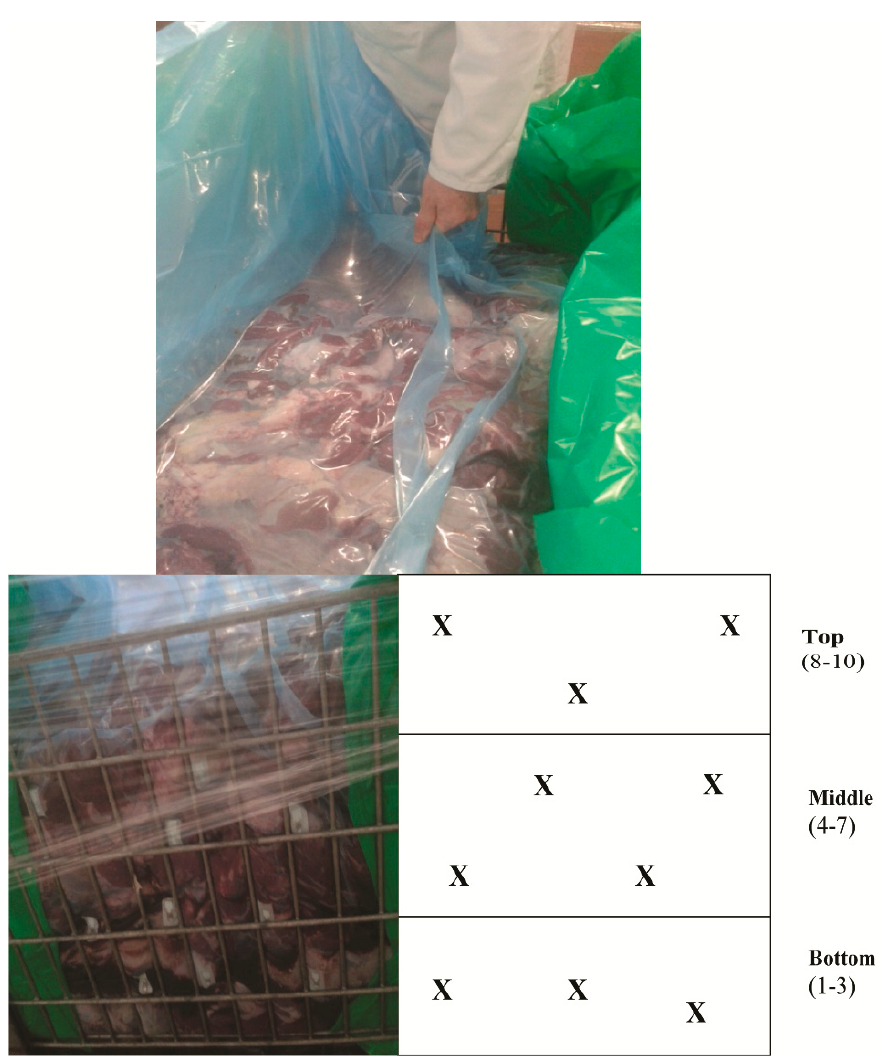
Figure 1. Top view of a bulk bin with vacuum-packaged meat ( top ) and its side view in a bin ( bottom left ) showing the location of individual O 2 sensors ( bottom right ).